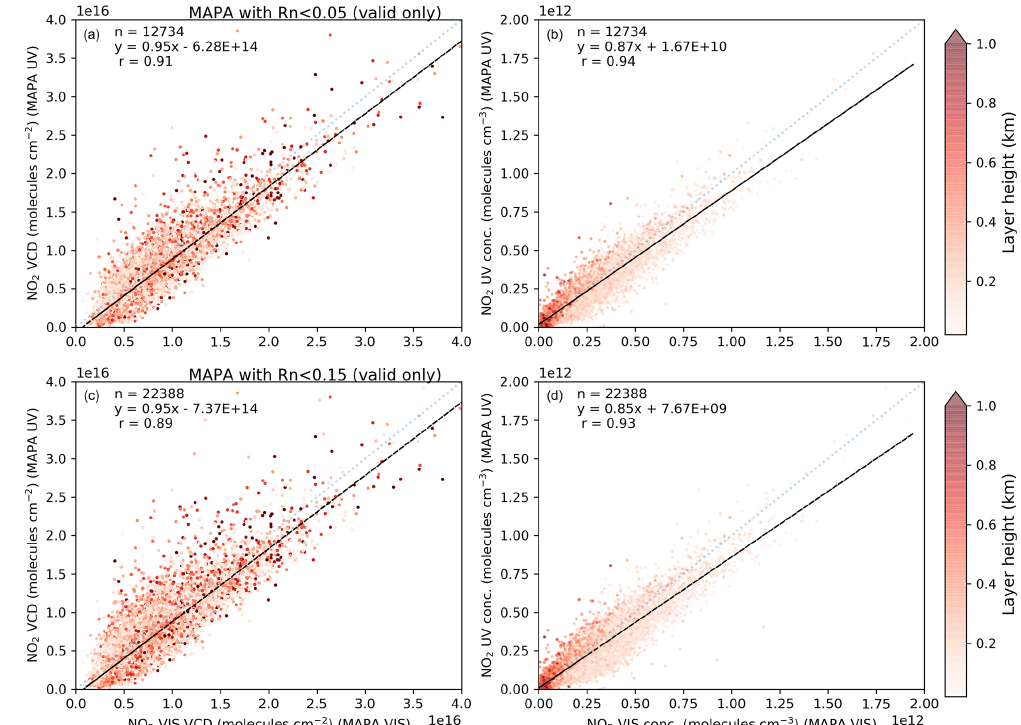
Figure A2. Comparison of NO 2 VCDs (a, c) and surface concentrations (b, d) retrieved in the UV against those retrieved in the visible. Please note that the number of valid data points shown in this figure corresponds to the number of valid overlapping retrievals in UV and the visible. The number of valid retrievals for NO 2 in UV shown in Table 2 corresponds to the R n flag with a threshold < 0 .